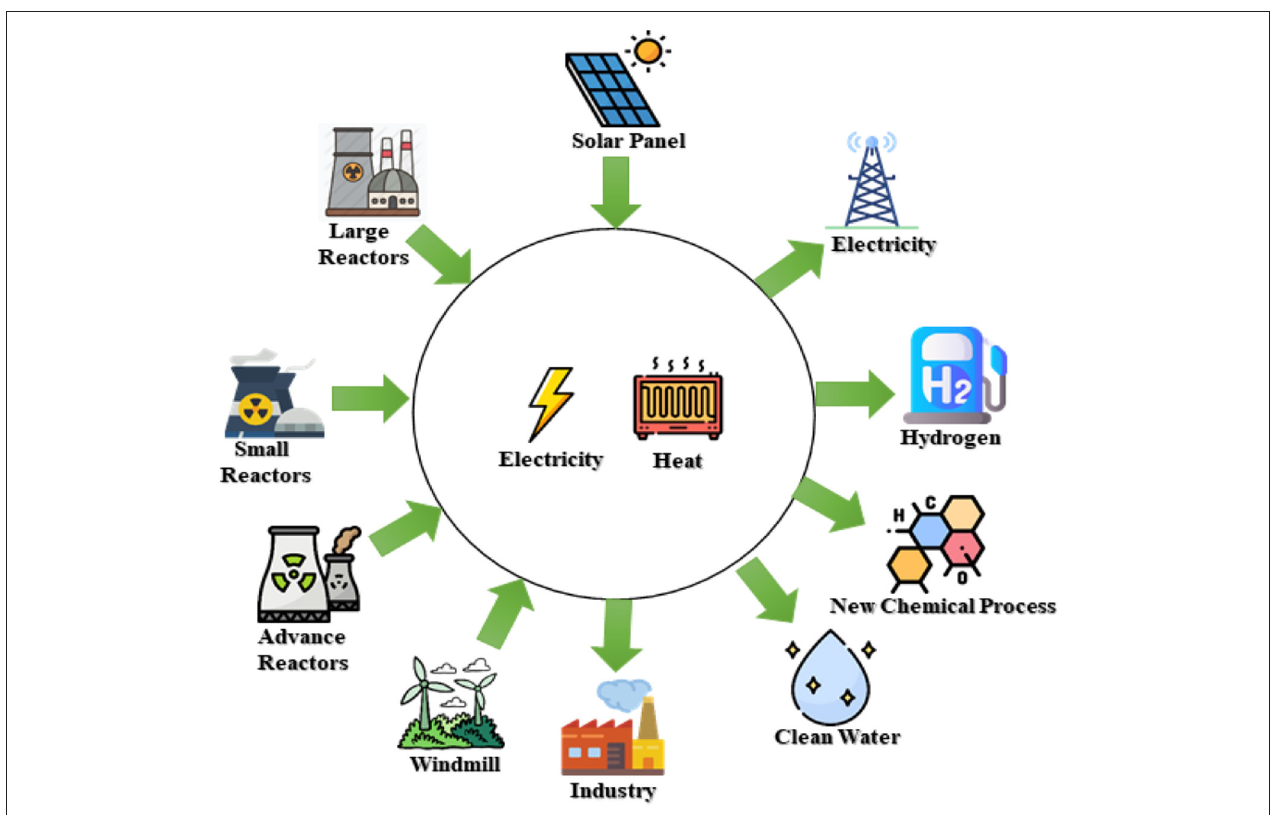
FIGURE 1 | Maximizing energy utilization through novel systems integration.